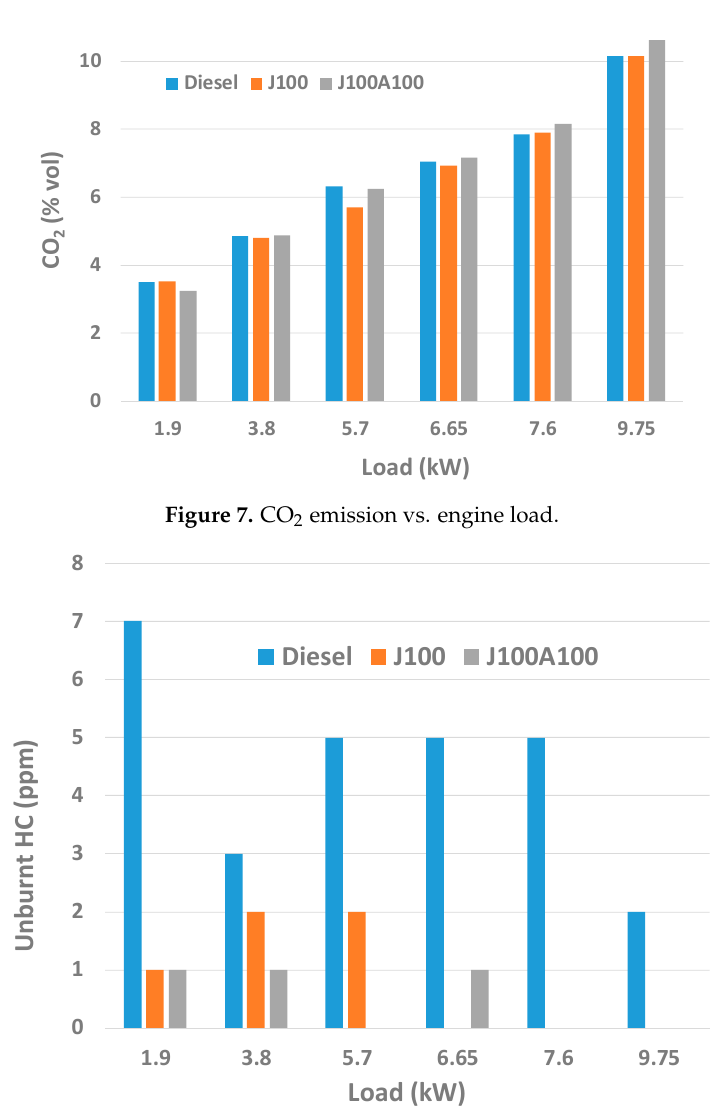
Figure 8. UHC emission vs. engine load.